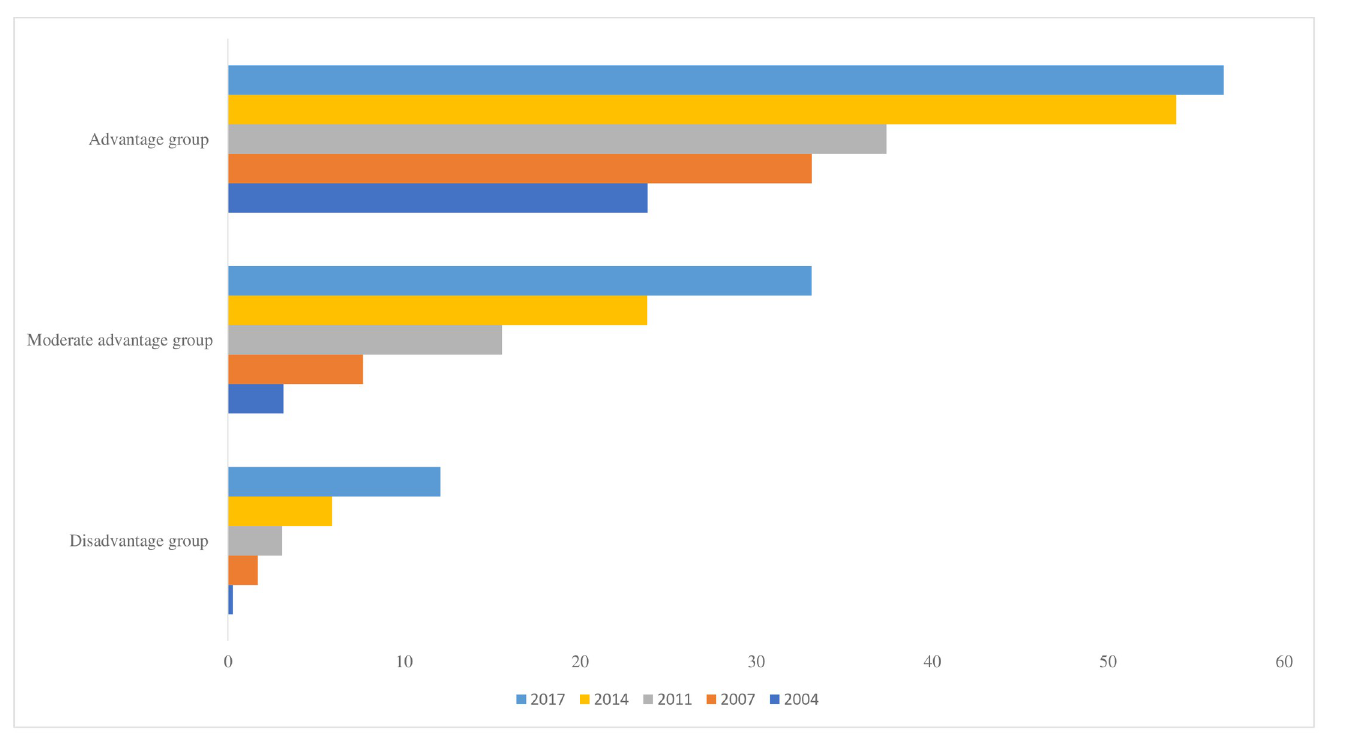
Fig 4. Change in caesarean section use across type of disadvantages characteristics in Bangladesh, 2004-2017/18.